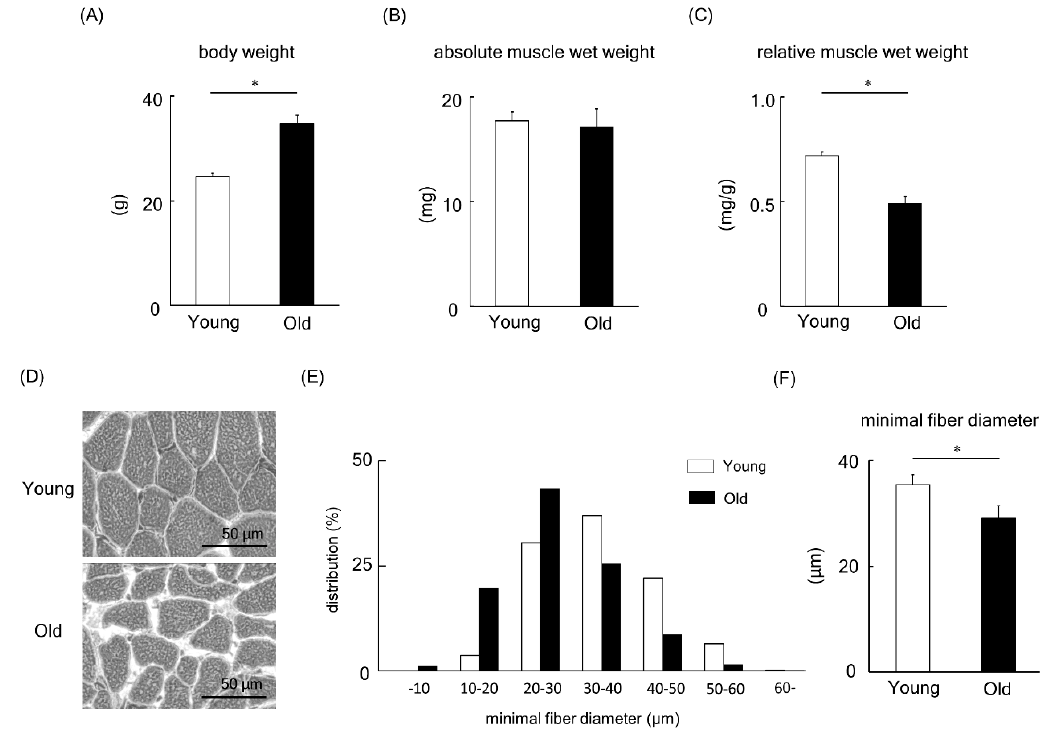
Figure 6. Body weight ( A ), absolute plantaris muscle wet weight ( B ), and muscle weight relative to body weight ( C ) in young and old mice. ( D ) Typical images from hematoxylin-eosin-stained plantaris muscles of young and old mice. The frequency distribution ( E ) and the mean value ( F ) of minimum muscle fiber diameter of plantaris. Values are means ± SEM; young: 10 weeks old, n = 5; old: 100 weeks old, n = 7. *: p < 0.05.